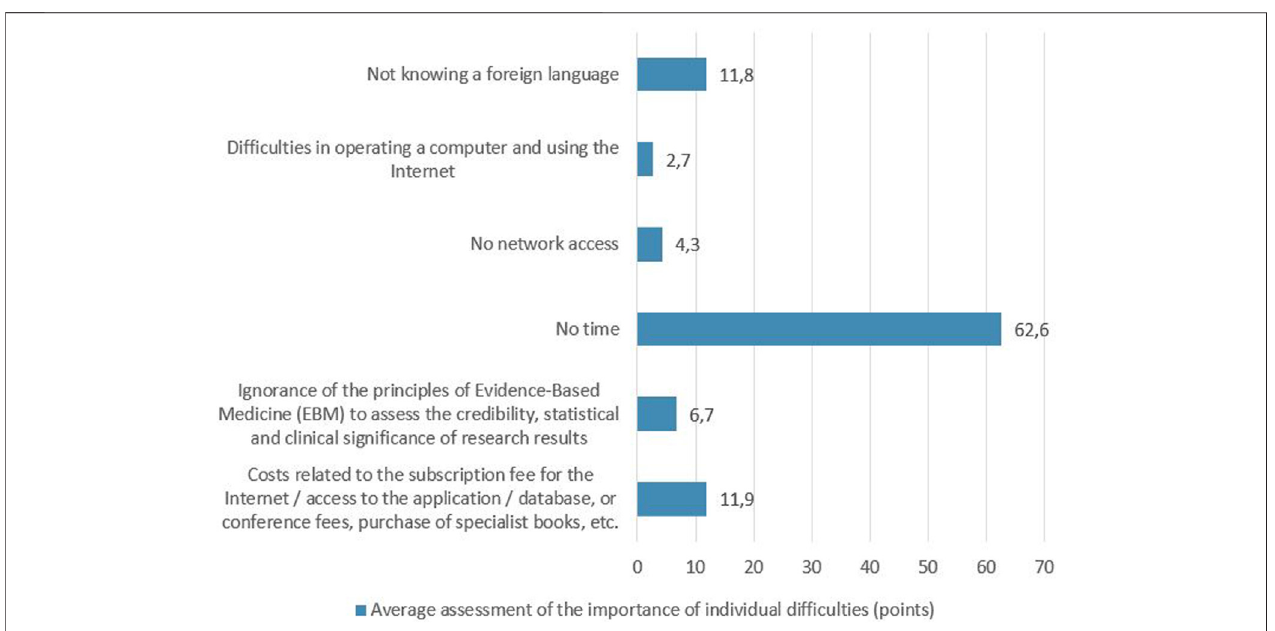
FIGURE 1 | Average assessment of the importance of individual dif fi culties.